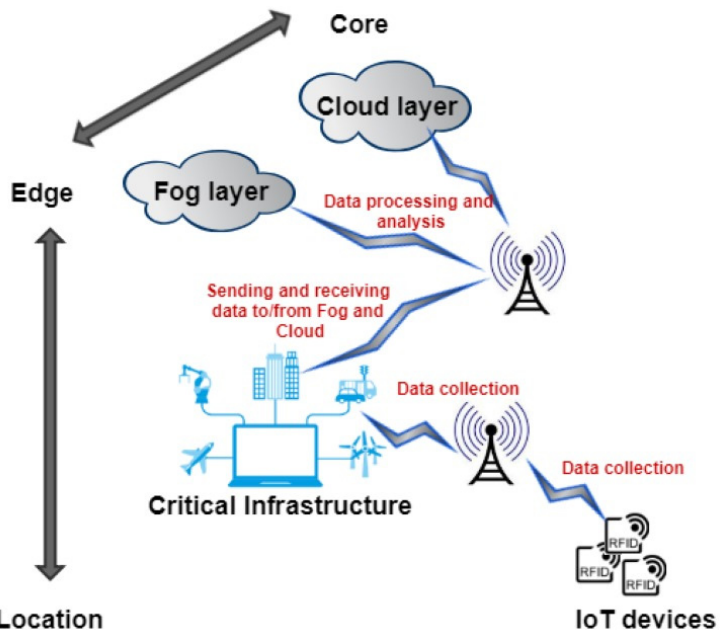
Figure 7. Fog-water collector system (reprinted from Reference [39] under the terms of the Creative Commons Attribution License CC BY 4.0 license, https://creativecommons.org/licenses/by/4.0/ (accessed on 25 October